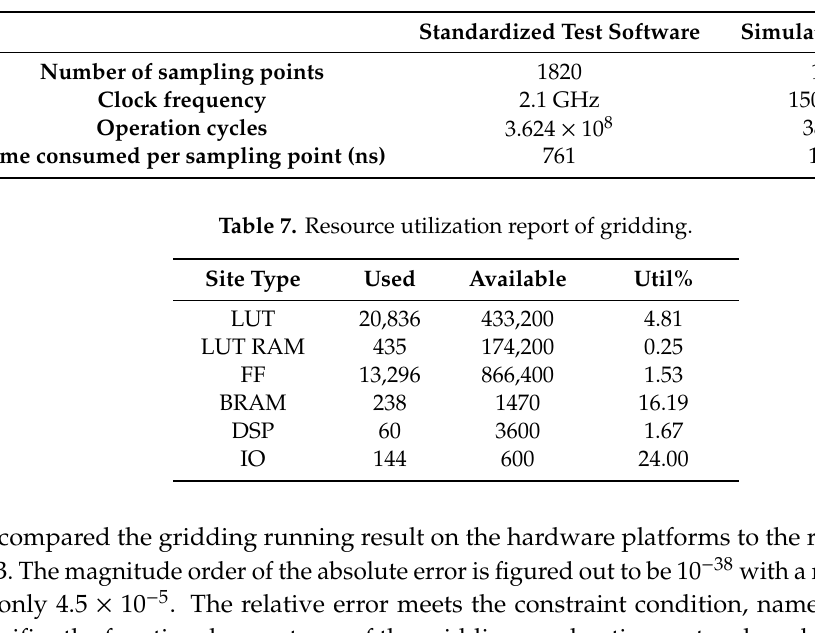
Table 6. Comparisonof gridding acceleration ratio.